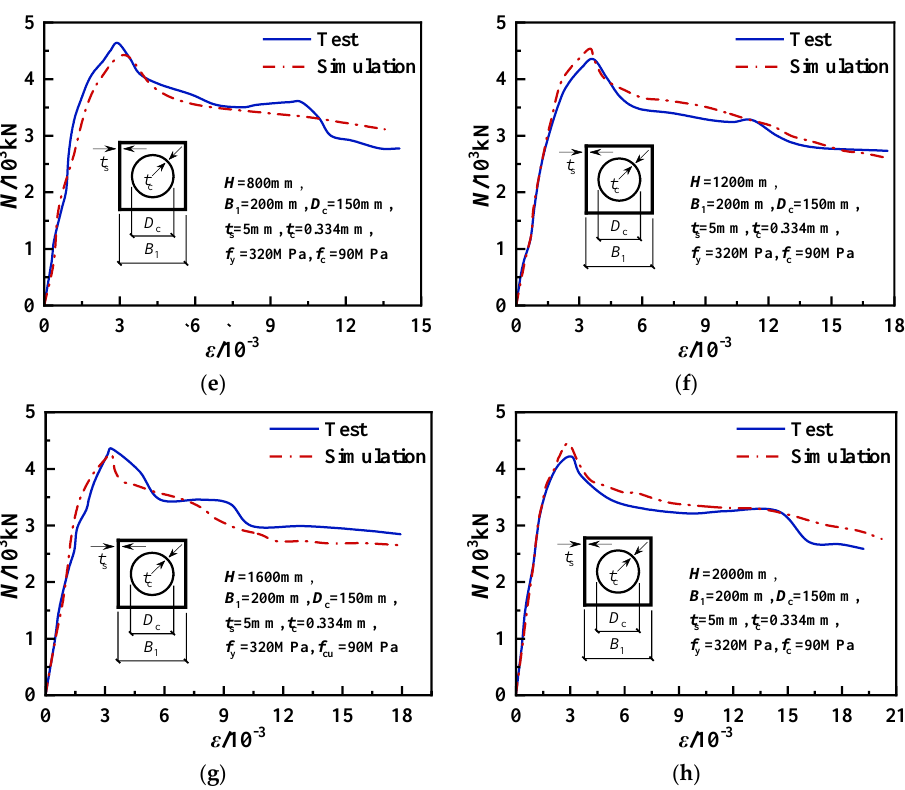
Figure 4. Comparison of N - ε curves between simulation and test: ( a ) A-1. ( b )B-1. ( c ) C-1. ( d ) D-1. ( e ) CFSSC-3. ( f ) CFSSC-6. ( g ) CFSSC-8. ( h ) CFSSC-10.